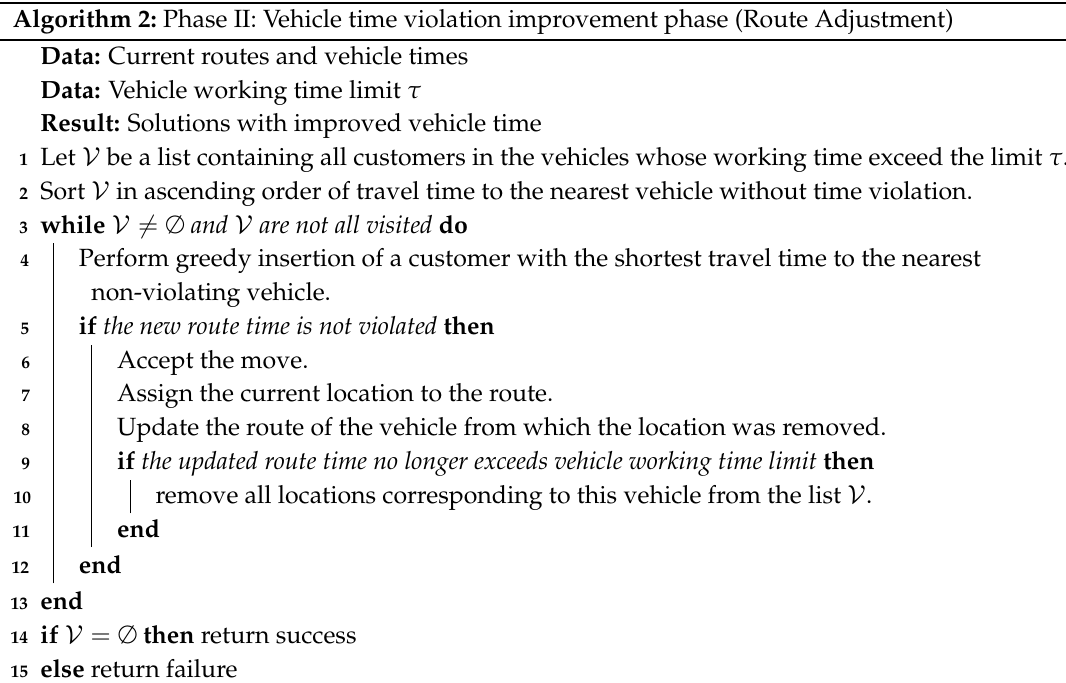
Algorithm 2: Phase II: Vehicle time violation improvement phase (Route Adjustment) Data: Current routes and vehicle times Data: Vehicle working time limit